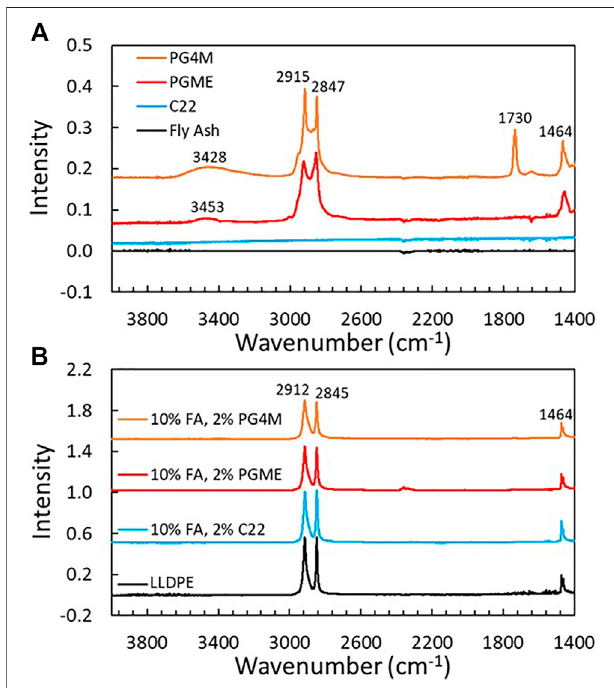
FIGURE 6 | FTIR spectra of selected (A) fl y ash and compatibilizers and (B) polymer samples including unaltered PCR LLDPE and blends with the highest concentration of both fl y ash and compatibilizer.